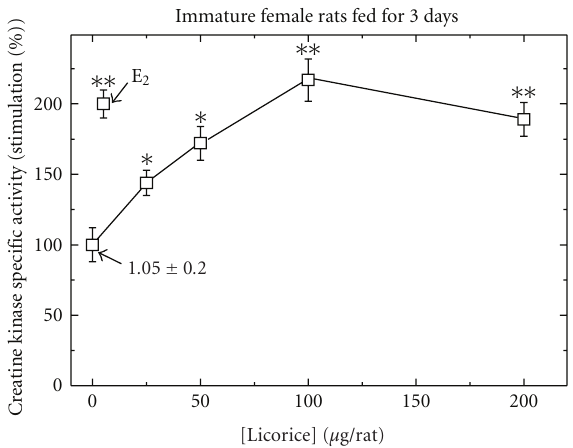
Figure 5: Dose-dependent stimulation of creatine kinase (CK) specific activity by licorice, fed daily for 3 days, in pituitary from immature female rats, compared to feeding with single dose of E 2 . Rats were treated and assayed for CK activity as described in Section 2. Results are means ± SEM for n = 5 rats/group. Experimental means compared to control means: ∗ P < . 05 and ∗∗ P < . 01. Basal activity was 1 . 05 + 0 . 20 μ mol/min/mg protein.